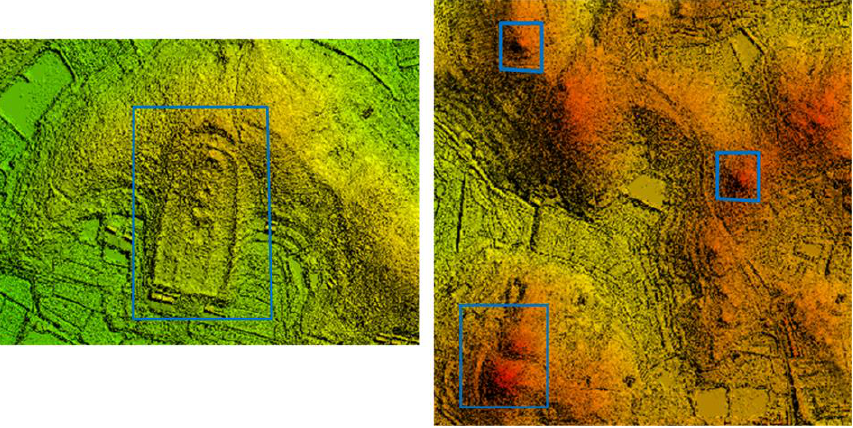
Figure 3. DSM display in Global Mapper 22.